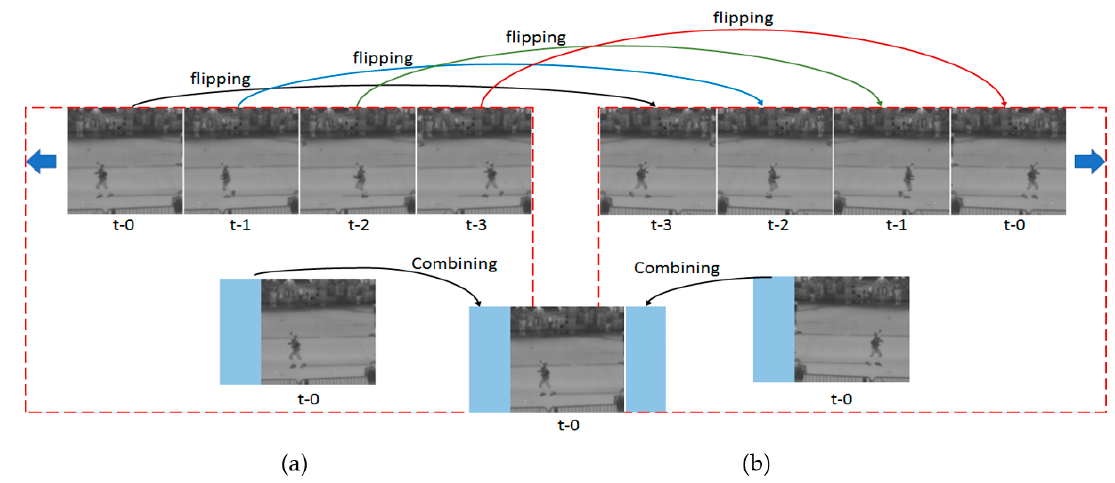
Figure 22. Example of our image prediction method.